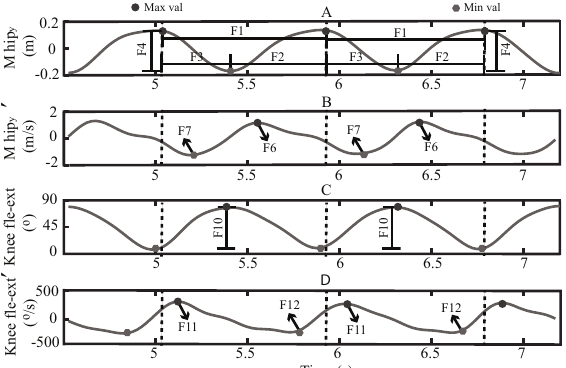
Figure 5. Features extraction process from the Kinect row data, ( A ) M_hip vertical movement signal, ( B ) M_hip vertical velocity signal, ( C ) nee flexo-extension signal and ( D ) Knee flexo-extension velocity signal.